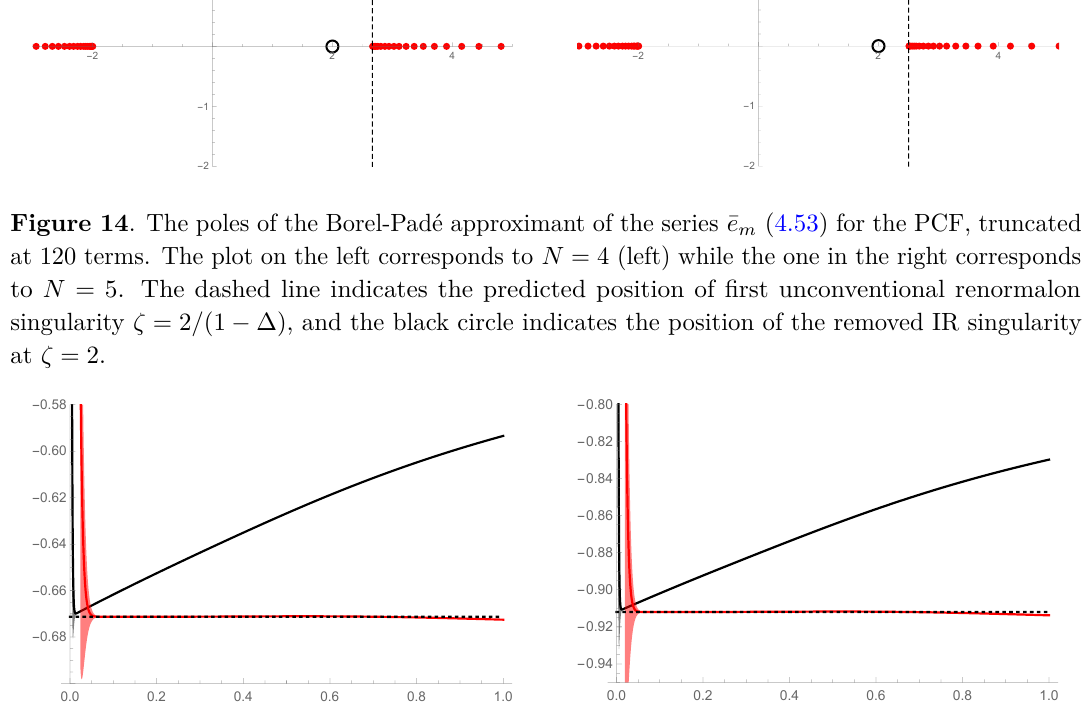
Figure 15 . Plot of the function f ( α ) defined in (4.57) for the PCF with N = 4 (left, black) and N = 5 (right, black), as well as their respective second Richardson transforms (red). The dashed line is the predicted asymptotic value ( C − − C + ) / (2 π i) . The shaded areas correspond to error estimates 1 1 from the convergence of the Padé